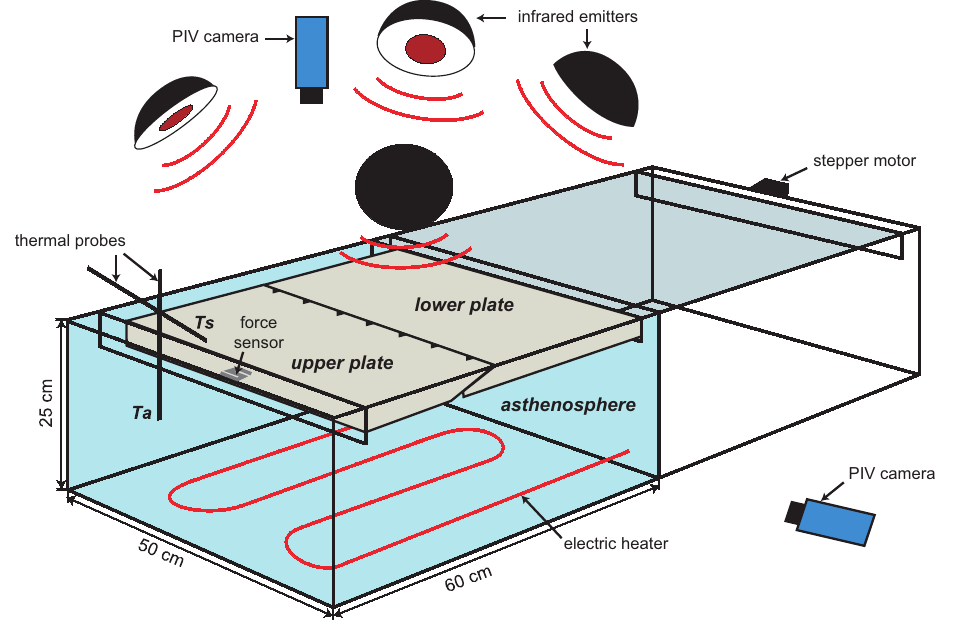
Fig. 1. 3-D sketch of the experimental set-up. Two lithospheric plates made of hydrocarbon compositional systems rest on the asthenosphere modeled by water. A temperature gradient is imposed in the model lithosphere. A thermo-regulator receives the temperature of the water and at the model surface measured by 2 thermal probes and automatically adjusts the length of the heat pulses produced by the lower electric heater and 4 infrared emitters. Plate convergence is imposed at a constant rate and a force sensor installed in the back of the upper plate measures the force in the horizontal convergence parallel direction. Model strain is monitored using a Particle Imaging Velocimetry system imaging the model surface. A second optional camera is employed to follow the model evolution from the